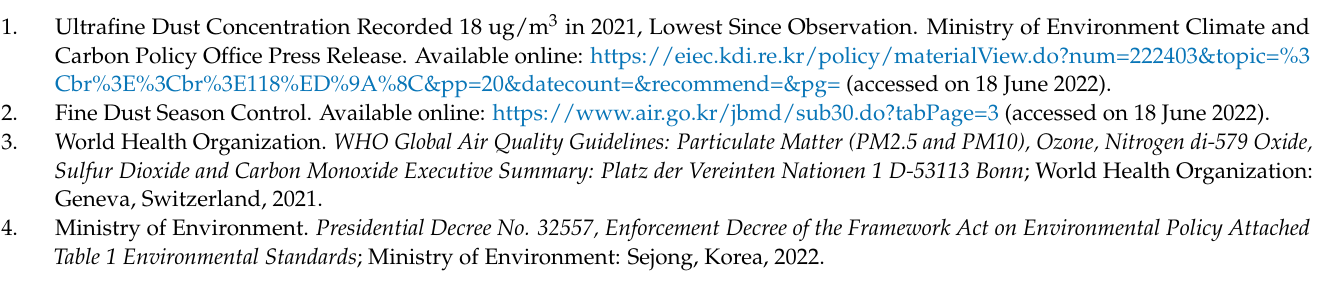
Table 1 Environmental Standards ; Ministry of Environment: Sejong, Korea,